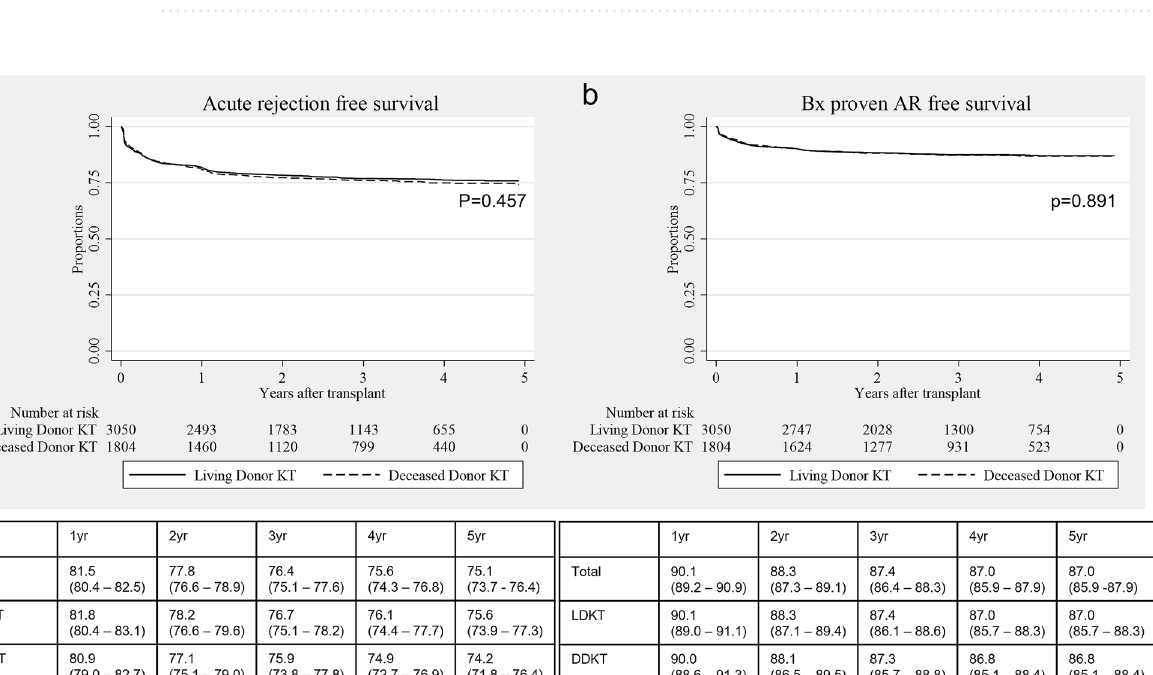
Table 3. Result of post-transplant kidney allograft biopsy. Multiple selections are allowed.